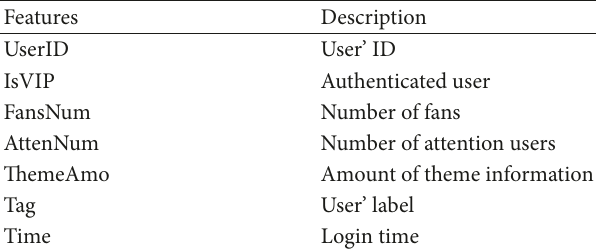
Table 1: Data structure and description of the user information.